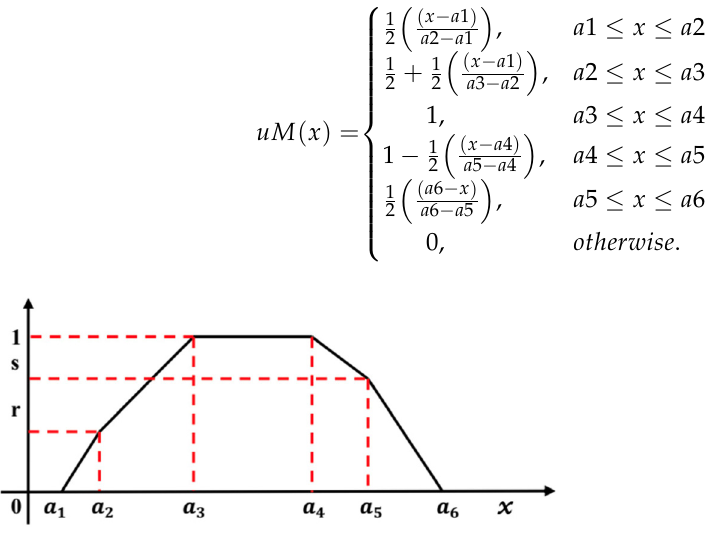
Figure 1. The HFN for x ∈ [0,